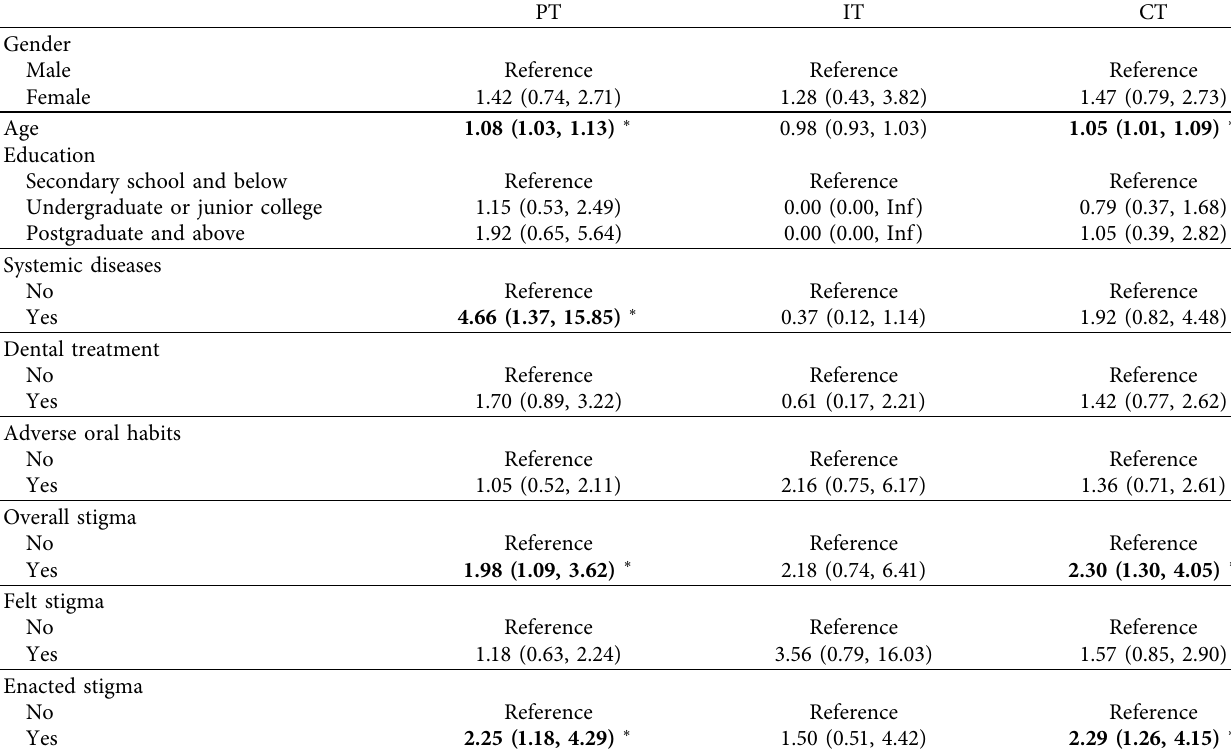
Table 5: Crude association of PT, IT, and CT with gender, age, education level, systemic diseases, dental treatment, adverse oral habits, overall stigma, felt stigma, and enacted stigma.